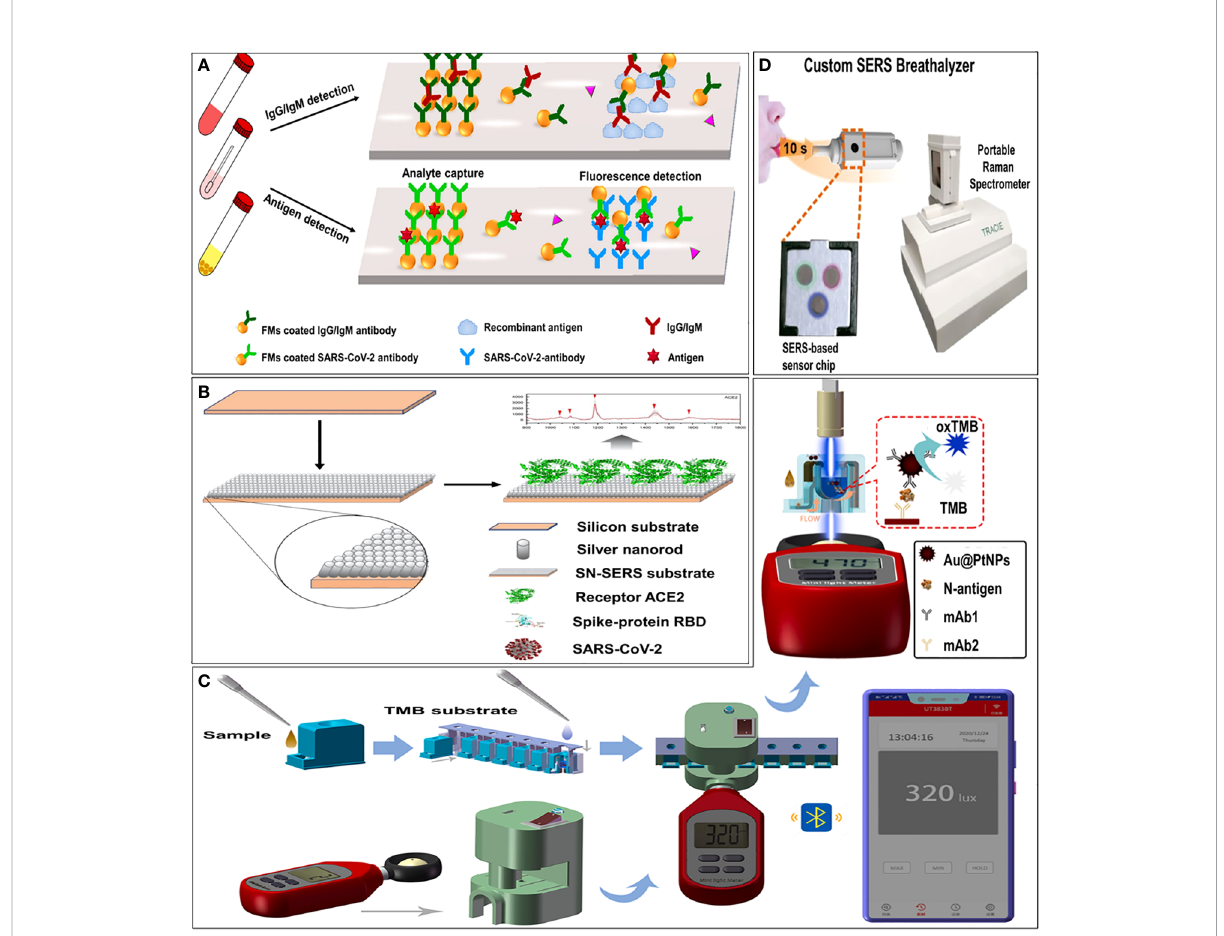
FIGURE 3 Examples of optical immunosensors. (A) Schematic illustration of the micro fl uidic fl uorescence immunoassay for IgG/IgM/antigen detection of SARS-CoV-2 (Lin et al., 2020). (B) Schematic illustration of principle of immunoreaction, optical signal transmission and photometer sensing (Zhang et al., 2021). (C) Schematic illustration of procedure of smartphone-based NLICS (Liang et al., 2021a). (D) Schematic illustration of overview of our SERS-based strategy to identify COVID-positive individuals using their breath volatile organic compounds (BVOCs) (Leong et al.,